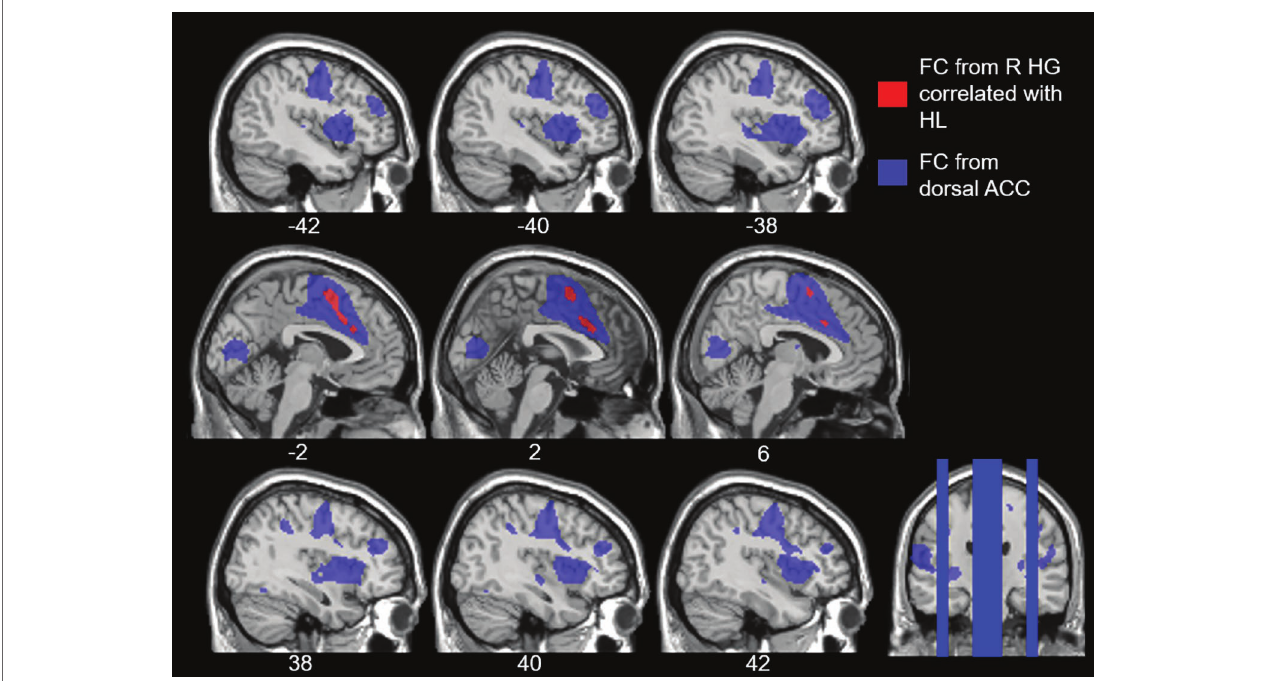
FIGURE 5 | Overlay of the voxels that expressed increased functional connectivity (FC) to right Heschl’s gyrus (HG) with age-related hearing loss (HL) across all frequencies, voxelwise p < 0.001 uncorrected, cluster-level p < 0.05 FDR (red), and the cingulo-opercular network (blue). The cingulo-opercular network was defined using the results of the dorsal anterior cingulate (ACC) as a seed ROI in a seed-to-voxel functional connectivity analysis, voxelwise p < 0.001